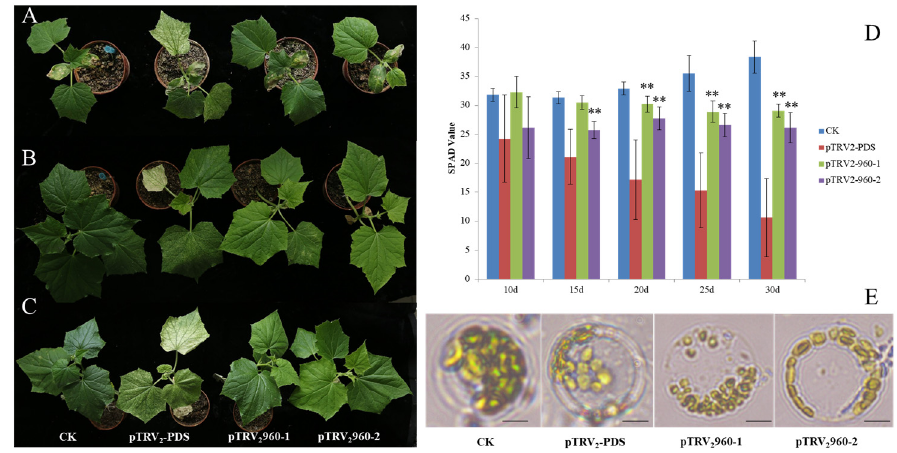
Figure 5. Virus-induced gene silencing in plants infected with TRV vectors of tandem 13-lipoxygenase genes in cucumber leaves. Cucumber leaf morphology co-infected with empty TRV 2 , pTRV 2 - PDS , pTRV 2 - 960-1 , and pTRV 2 - 960-2 after eight days post-inoculation (dpi) ( A ), 16 dpi ( B ), and 24 dpi ( C ). ( D ) Chl meter (SPAD) value of cucumber leaves co-infected with empty TRV2, pTRV2-PDS, pTRV2- 960-1 , and pTRV2- 960-2 at different dpi. ( E ) Chloroplast morphology of the representative protoplasts isolated from cucumber leaves, co-infected with empty TRV 2, pTRV 2 -PDS, pTRV 2 - 960-1 , and pTRV 2 - 960-2 . Scale bar = 10 μ m. ** stands for significant difference ( p < 0.01).